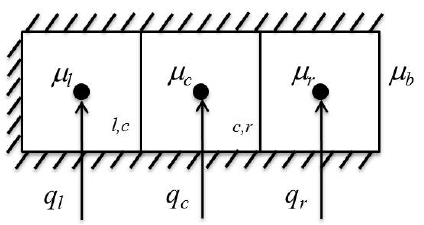
Figure 4. Schematic of a simple profile with Dirichlet boundary conditions on the right and left (M r ,M l ) a constant source ( Q s ), and steady-state, variably saturated flow. In this case, there exists a water divide in the domain. In the theory, the vertical and horizontal extent of the cross section is assumed to be constant.